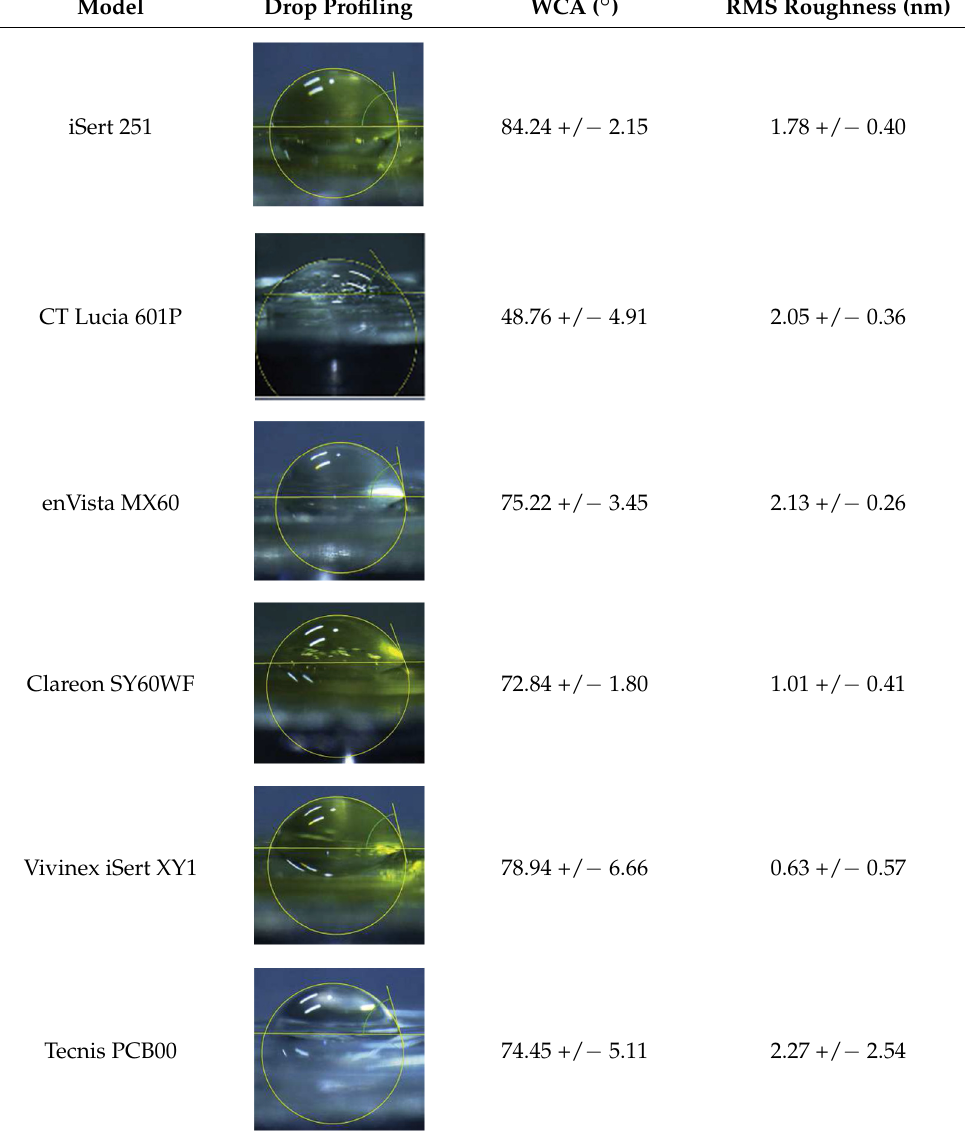
Table 4. Drop profiles for evaluation of the WCA for the 6 commercial considered IOLs and corresponding root mean square roughness measured by AFM. Adapted with permission from Ref. [91] C. de Giacinto et al. Surface Properties of Commercially Available Hydrophobic Acrylic Intraocular Lenses: Comparative Study, J. Cataract Refract. Surg. 2019 , 45 , 1330–1334. © Wolters Kluwer Health,